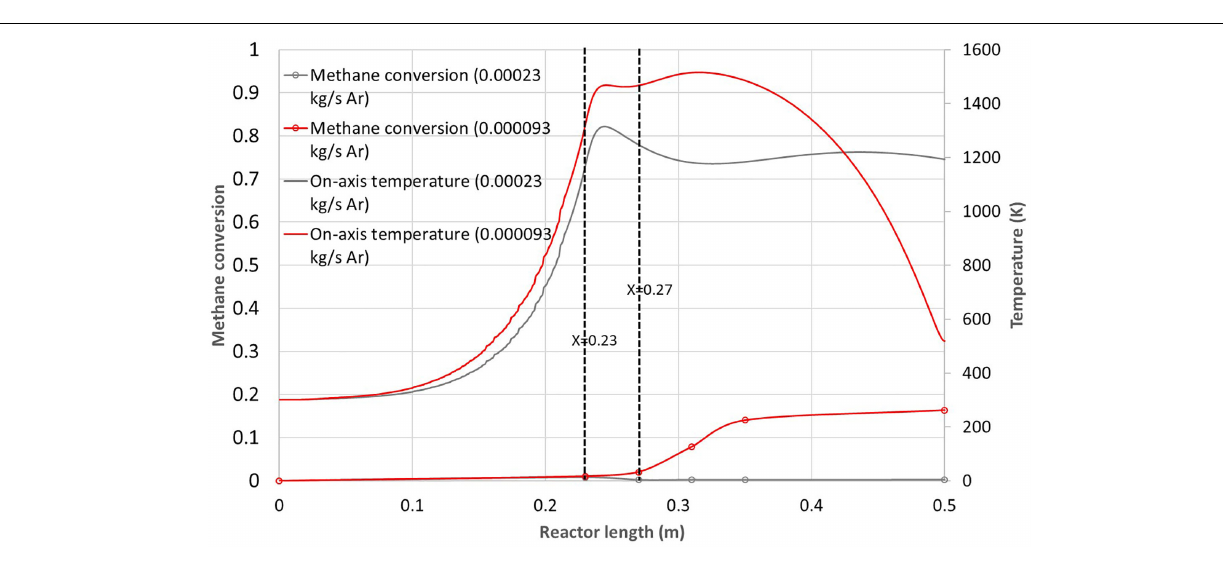
FIGURE 8 | Methane conversion and on-axis temperature vs. reactor length for the 230 mm dual tube configuration and two different argon flow-rates (2.3 × 10 - 4 kg.s - 1 and 9.3 × 10 - 5 kg.s - 1